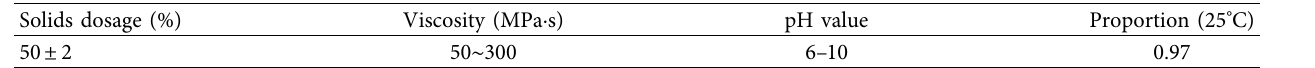
Table 3: Performance of SBR latex.